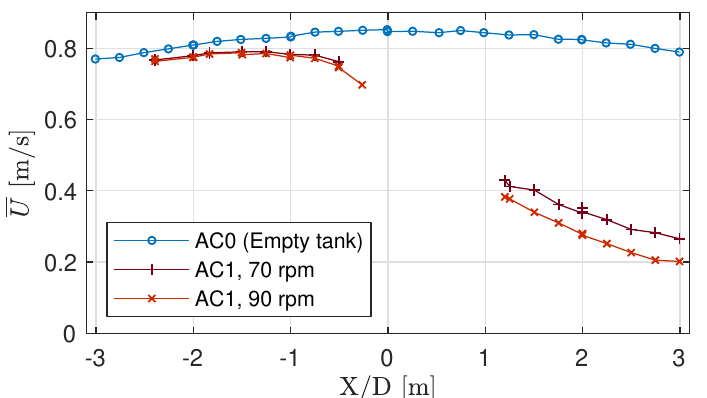
Figure 5. Transect along primary turbine centreline ( Y / D = 0), showing inflow and wake at varying rotational speed for configuration AC1, with AC0 for comparison.